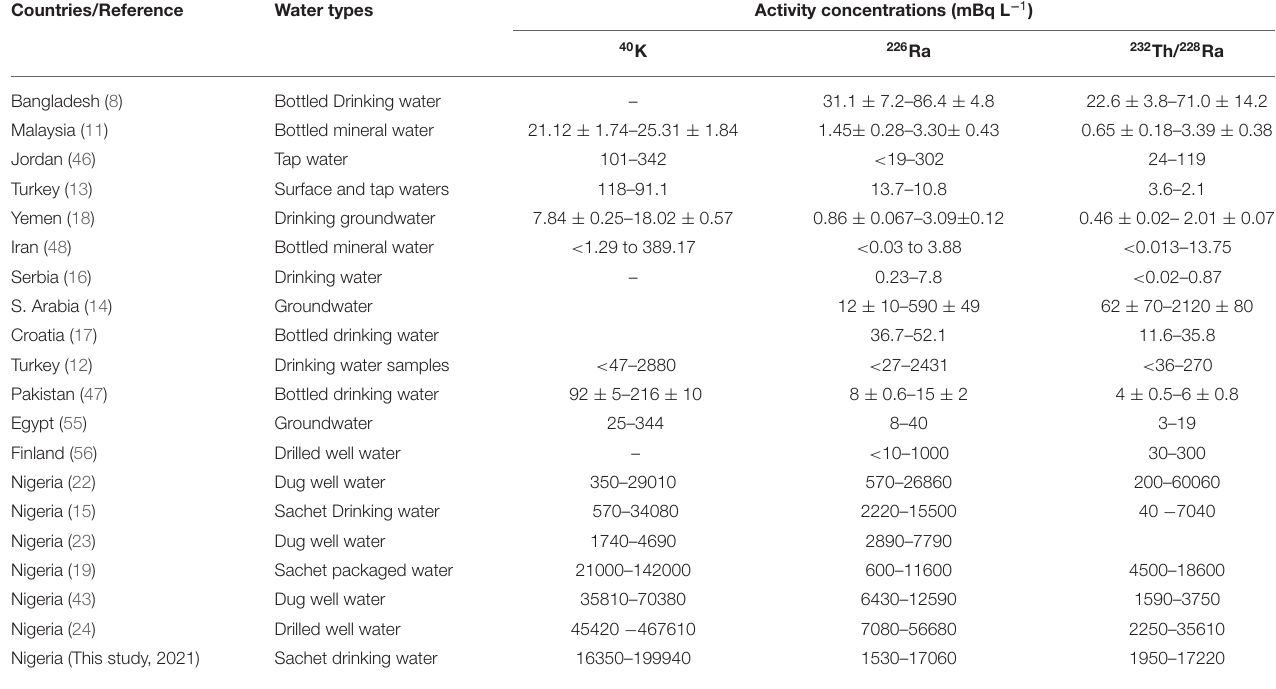
TABLE 2 | Comparison of 40 K, 226 Ra, and 228 Ra concentration ranges in various water types with results reported from other countries.